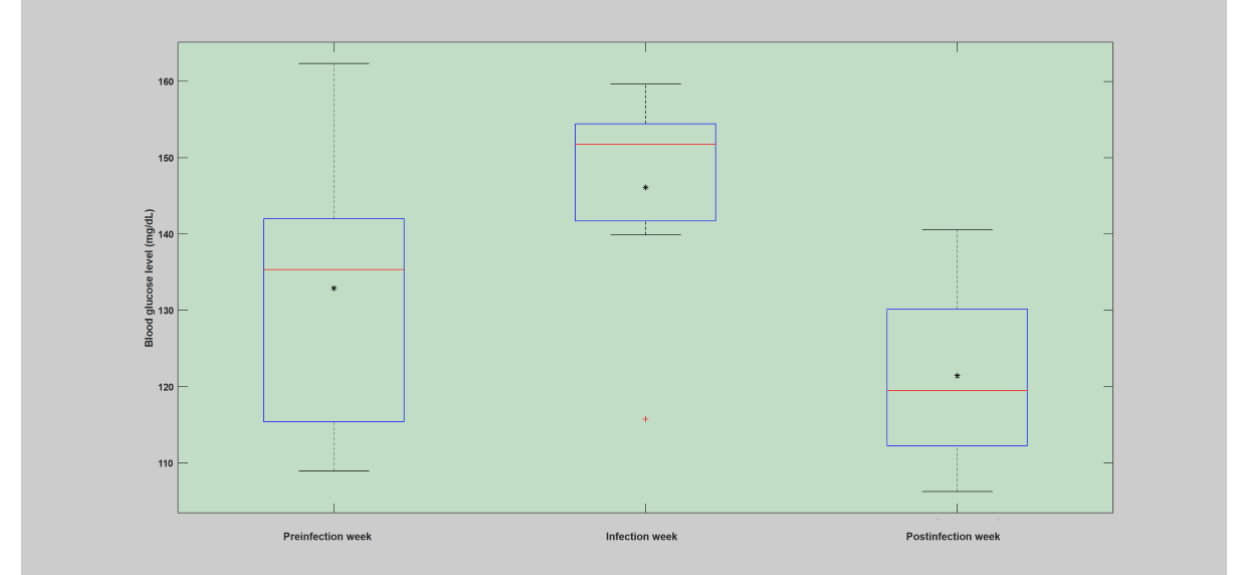
Figure 3. Analysis of blood glucose levels during the preinfection week, infection week, and postinfection week based on the first case of infection (flu). The asterisk shows the mean value, and the red line depicts the median value for the week.